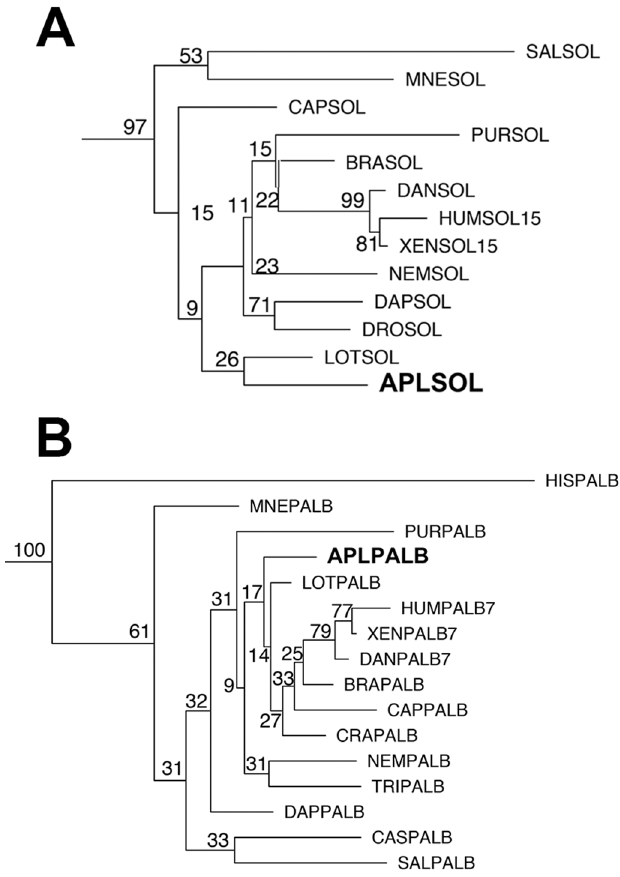
Fig 2. Phylogeny of SOL and PalB calpain families. Speciesabbreviationsand their phylogenetic classification and common name are detailedin Table 1. All reference numbers for sequencesare in S1 Table. The analysisis describedin the methods (the plot is from the RAxML analysis). Aplysia calpainsare in larger font. (A) SOL calpainfamily. (B) PalB